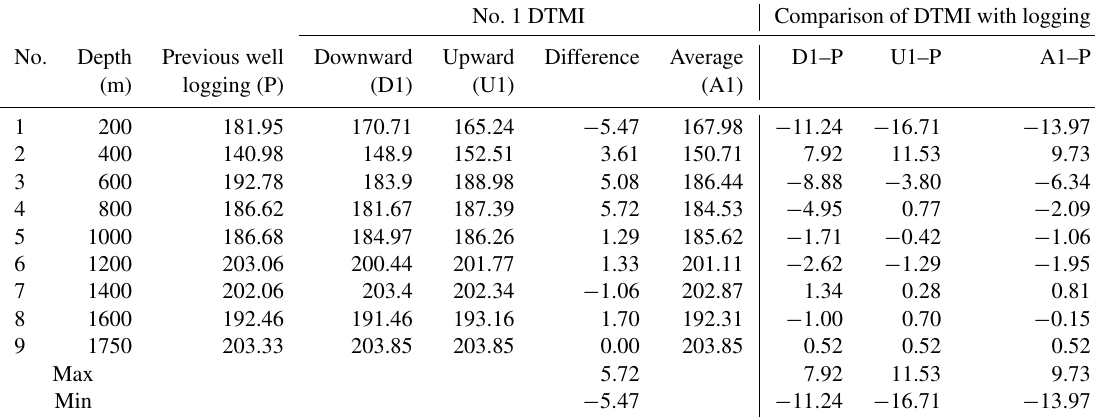
Table 11. Measured azimuth angle of the Xingreguan-2 well, Beijing.